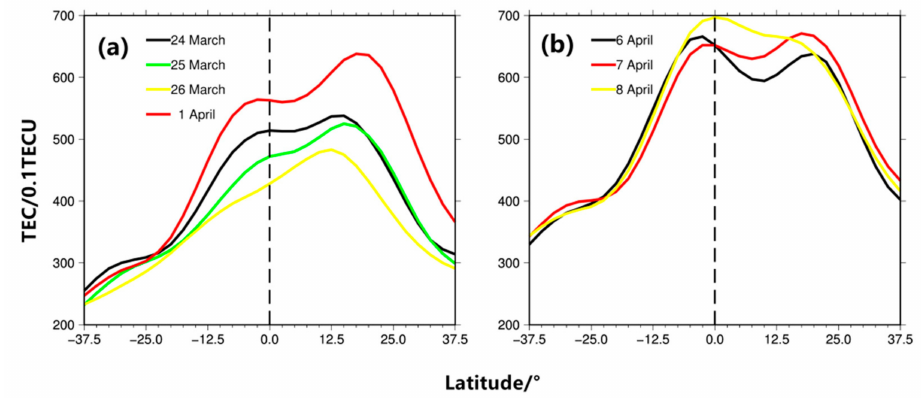
Figure 7. Shape of the equatorial ionization anomaly for the 105 ◦ E at 11:00 Local time (4:00 UTC) during ( a ) periods 2 and 3 and ( b ) period-1. A relevant range of latitudes is shown: 37.5 ◦ N–37.5 ◦